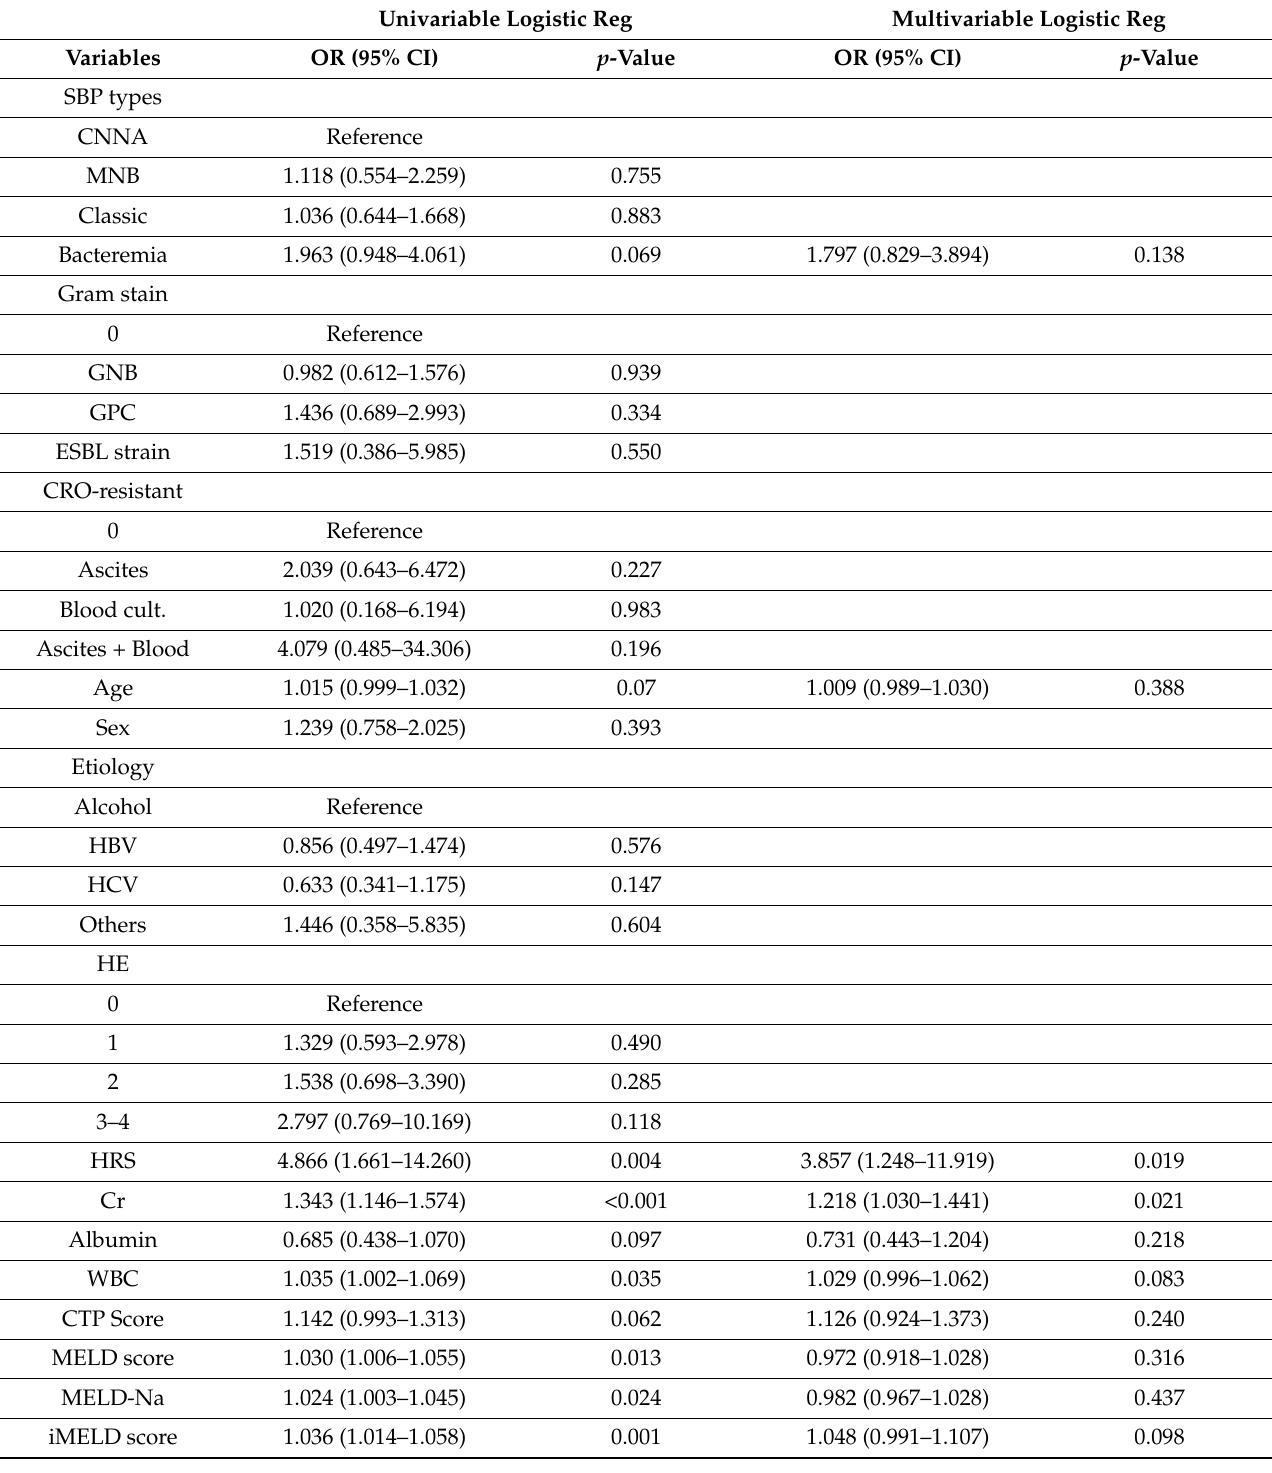
Table 7. Univariable and multivariable logistic regression analysis for predicting 6-month mortality. Univariable Logistic